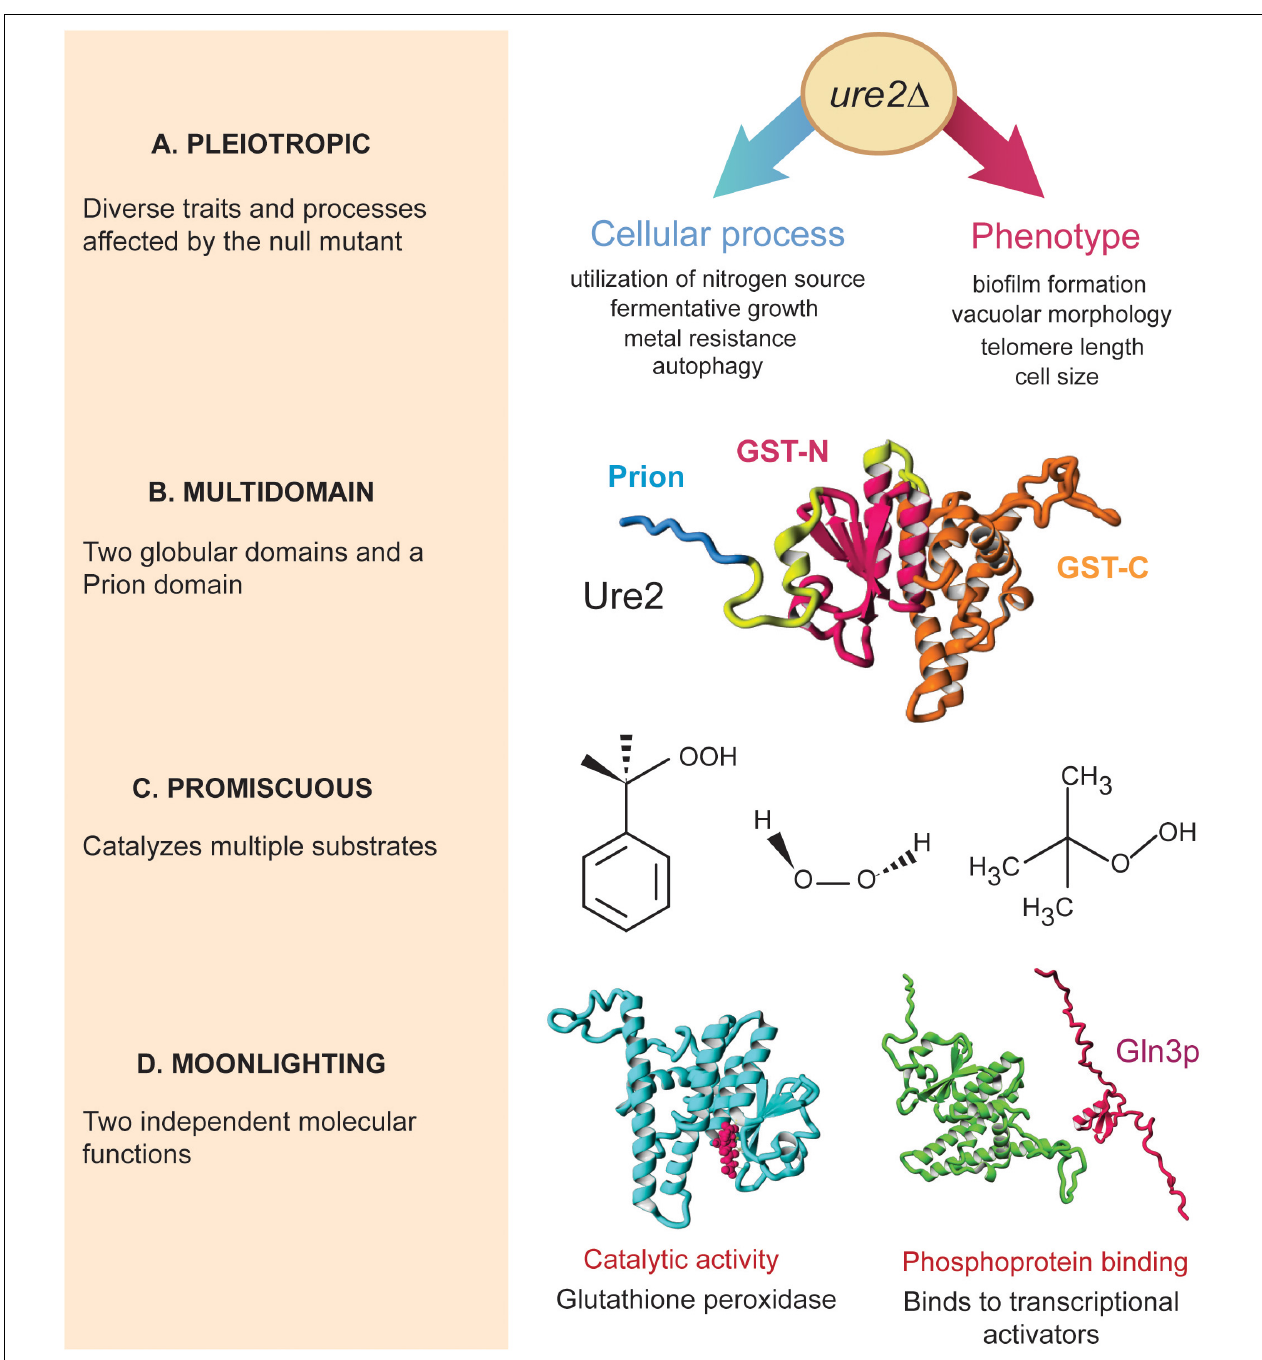
FIGURE 1 | Different forms of protein multifunctionality in Ure2p. The Ure2 protein from budding yeast is a peroxidase enzyme that can form prions and is directly involved in nitrogen-catabolite repression by binding to and sequestering phosphorylated transcription factors in the cytoplasm, such as Gln3. (A) Deletion of URE2 results in numerous phenotypes and observable traits related to different cellular pathways, which makes Ure2 a pleiotropic protein; only representative phenotypes associated to ure2 (cid:49) are shown. (B) Ure2 is a multidomain protein composed of an unstructured prion domain in addition to two globular domains typical of glutathione S-transferases (GST-N and GST-C). (C) The enzymatic activity of Ure2 is highly promiscuous: in vitro , Ure2 catalyze reactions with diverse substrates, involving different reaction mechanisms, within a single active site. Three different substrates for the glutathione-peroxidase activity of Ure2 are shown (from left to right: cumene hydroperoxide, hydrogen peroxide, and tert-butyl hydroperoxide). (D) The catalytic and binding activities of Ure2 are independent from one another: mutants lacking the Gln3-regulatory activity maintain their catalytic activity and such protein moonlighting is not explained by gene fusion, alternative splicing, or differential proteolysis. Protein images were generated using structure data from Protein Data Bank entry 1GgY, or Raptor X-predicted structures from Uniprot accessions P18494 and P23202.